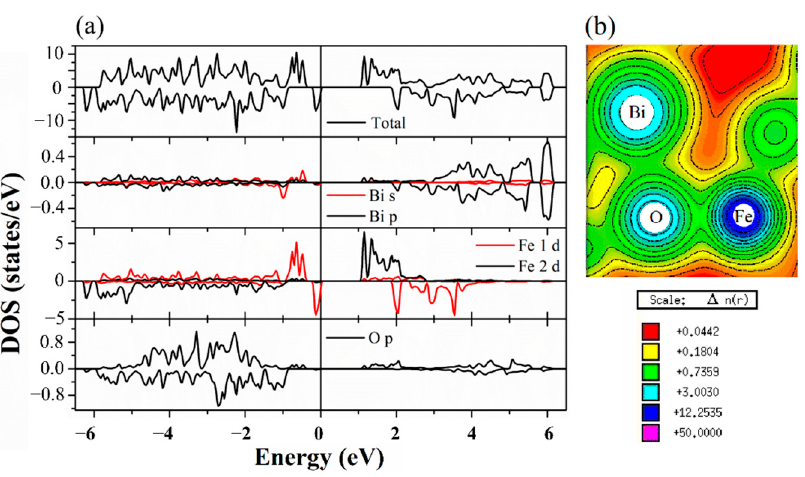
Figure 11. ( a ) Total and partial density of electronic states, and ( b ) the charge density distribution (110 plan) of BiFeO 3 in the thin film form.